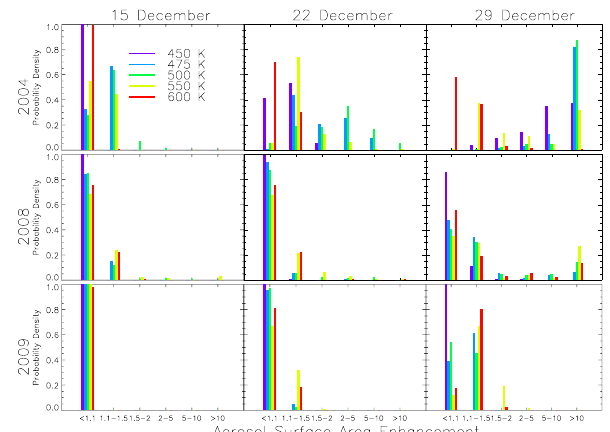
Fig. 7. Probability density distribution of maximum surface area density enhancement by STS along 7 day back-trajectories starting on MLS observations poleward of 75 ◦ N equivalent